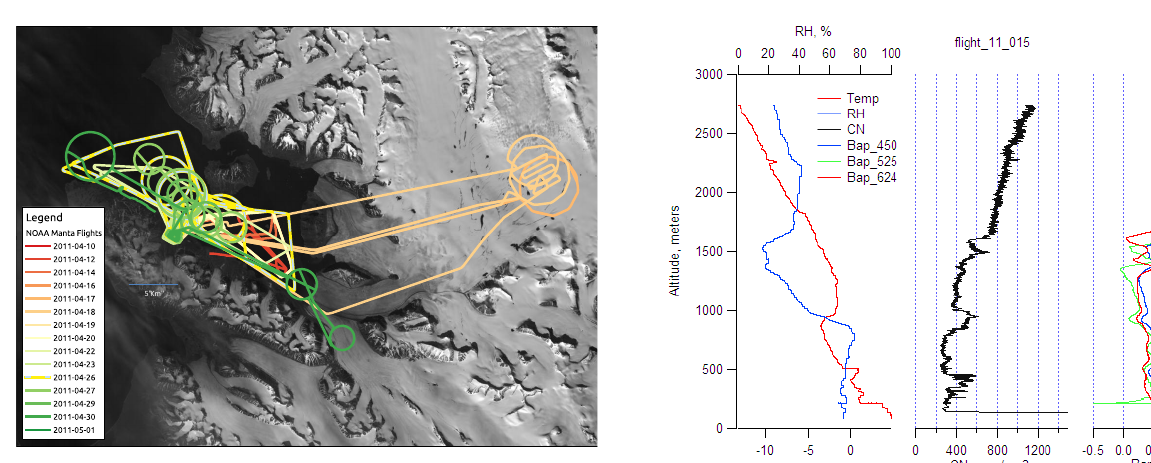
Figure 5. The first 45 minutes of flight 15 (26 April 2011) showing the initial assent from the airport to 2700 meters above the Kongsfjorden. Temperature and humidity (left), total particle number concentration (CN) (middle), and aerosol light absorption coefficient at three wavelengths (right). The mean CN concentration and aerosol light absorption coefficient measured at the Gruvebadet Laboratory during the STADS were 400 cm -3 and 0.56 Mm -1 , respectively.